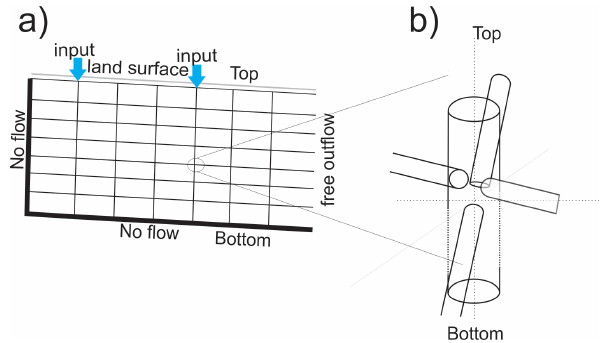
Figure 7. The model structure for the high-dip scenario. (a) The slope of the network is 0.99 in from top to bottom and 0.1 from left to right. The right boundary is a seepage face with free outflow. In- puts are on the top. (b) Junction geometry: high-dip (vertical) con- duits are positioned below the low-dip (horizontal)